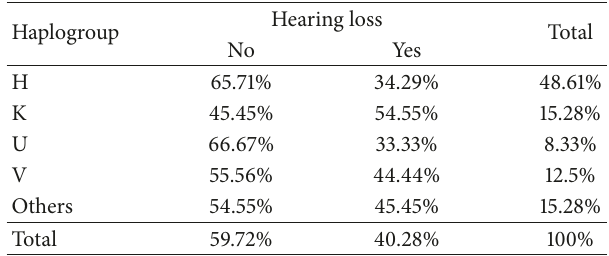
Table 2: Medical parameters of cancer patients including type of neoplasia and drug history ∗∗ .